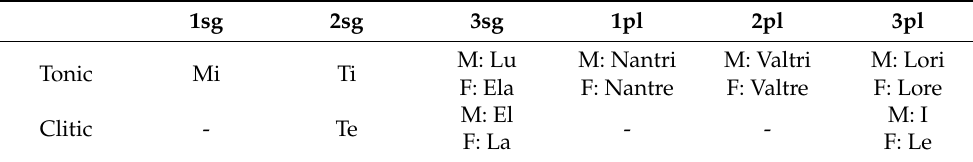
Table 1. Strong and clitic paradigms of subject pronouns in Venetan.